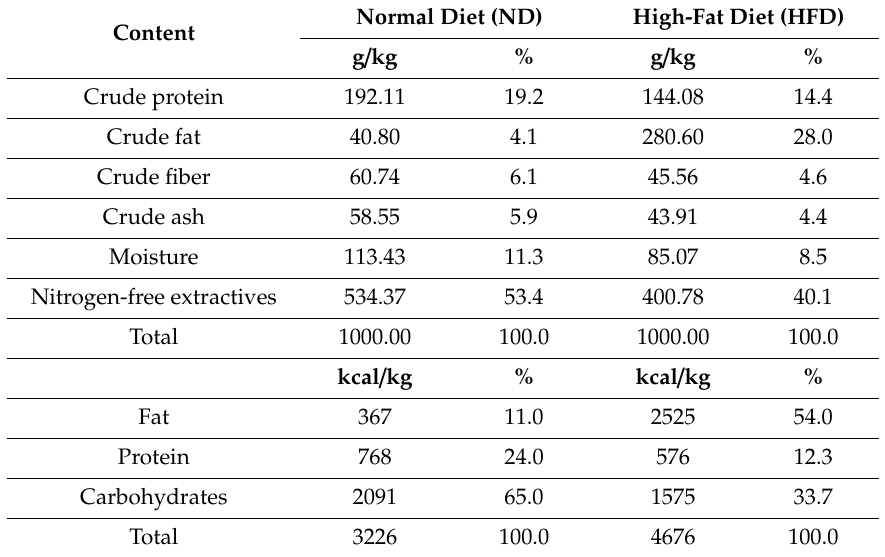
Fat Protein Carbohydrates